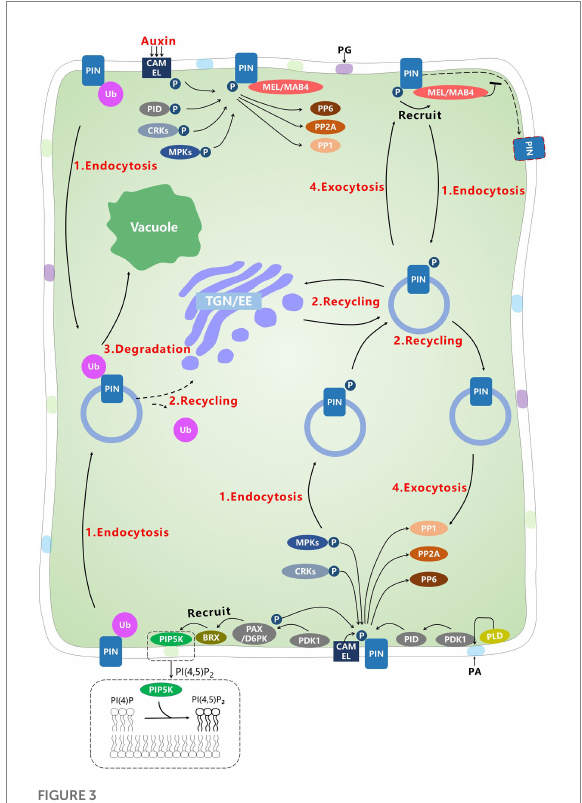
FIGURE 3 Post-translational modification regulates the localization of PINs. Kinases such as PID, D6PK, MPKs, and CRKs, directly phosphorylate PINs to change the polarity and transport activity of PINs. PAX recruits BRX to regulate the formation of PI(4,5)P2, which further influences the endocytosis of PINs. Phosphorylated PINs can recruit MAB4/MEL to maintain or change the localization of PINs through BFA-sensitive or BFA-insensitive endosomal vesicles. In addition, dephosphorylation regulated by phosphatases acts antagonistically to the changes caused by kinases. Among these proteins, only PAX/D6PK is localized only found to the basal PM.